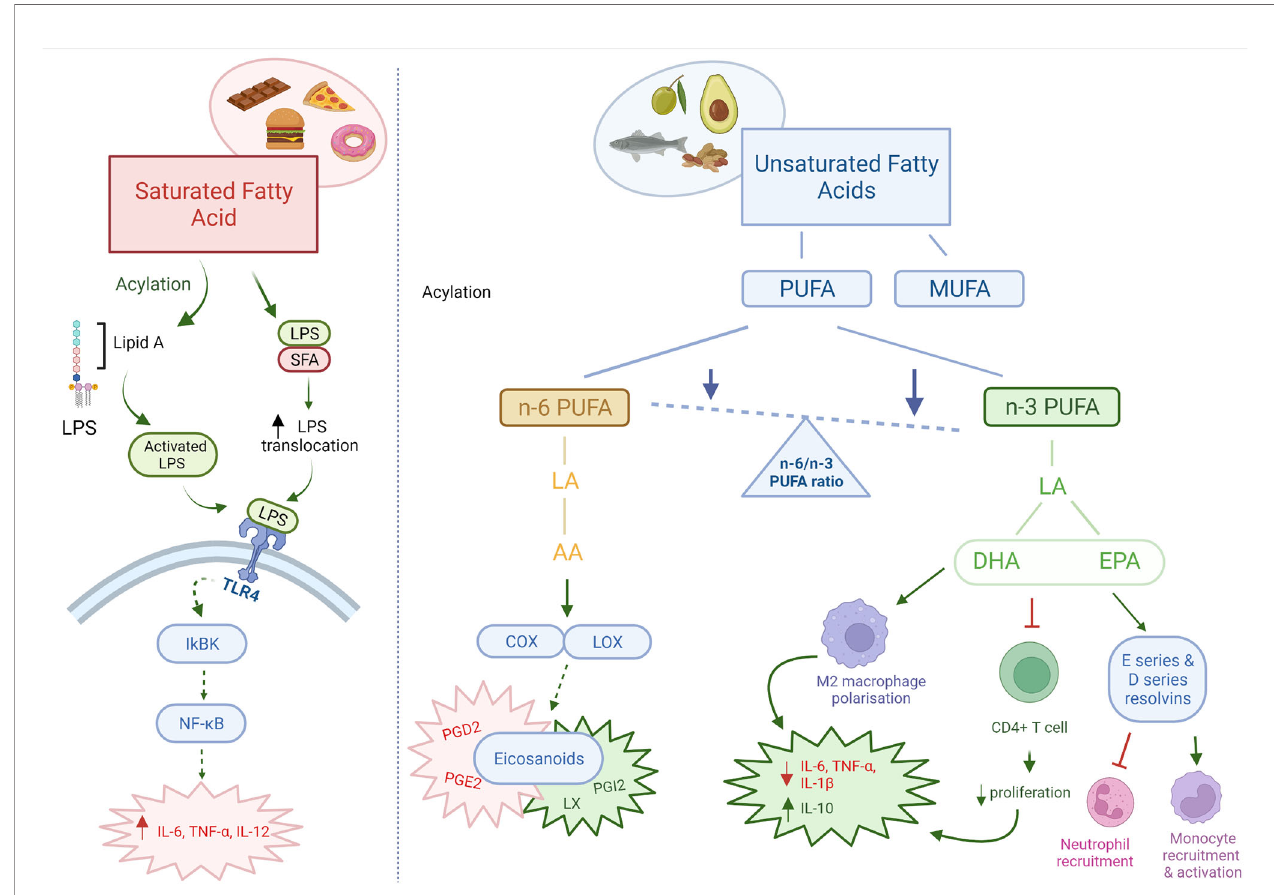
FIGURE 1 | Pro and anti-in fl ammatory effects of dietary fats. Dietary fats directly and indirectly act as both pro-in fl ammatory and anti-in fl ammatory mediators. Saturated fatty acids are pro-in fl ammatory in nature, through increased translocation and activation of LPS leading increased TLR4 signalling. n-3 PUFAs may be immunosuppressant through its effects on immune cells and intestinal barrier integrity. n-6 PUFAs are mainly pro-in fl ammatory, however can also produce anti-in fl ammatory eicosanoids. The ratio of n-6/n- 3 PUFAs are important in determining the in fl ammatory state in the body. Red: pro-in fl ammatory; Green: anti-in fl ammatory; Orange: pro- & anti-in fl ammatory. AA, arachidonic acid; PUFA, polyunsaturated fatty acid; MUFA, monounsaturated fatty acids; LA, linoleic acid; DHA, docosahexaenoic acid; EPA, eicosapentaenoic acid; COX, cyclooxygenase; LOX, lipoxygenase; PG, prostaglandin; LX, lipoxin. Created with